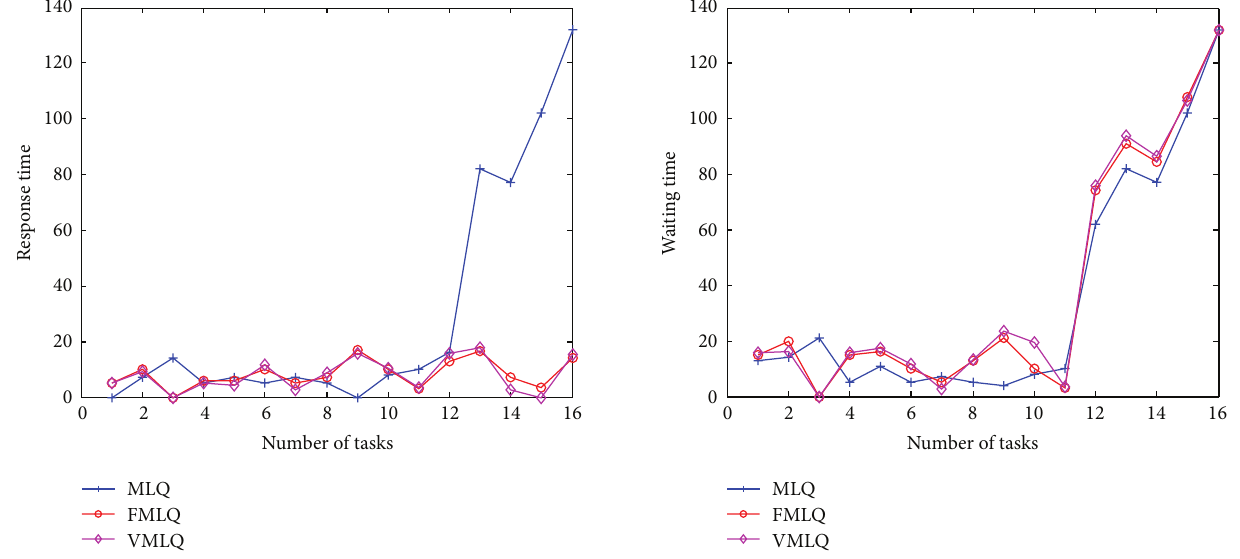
Figure 10: Response time (sample task set). Figure 11: Waiting time (sample task set).